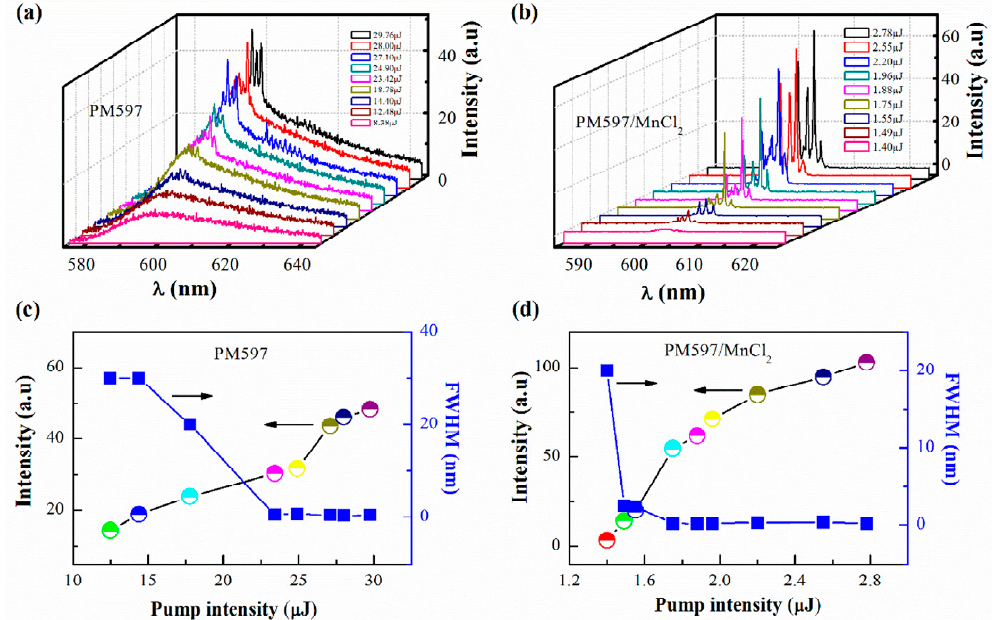
Figure 2. Emission spectra as a function of pump energies for ( a ) PM597 and ( b ) PM597-doped MnCl 2 systems, respectively. Main-peak intensities and FWHM of emission spectra versus pump energies for ( c ) PM597 and ( d ) PM597-doped MnCl 2 systems.